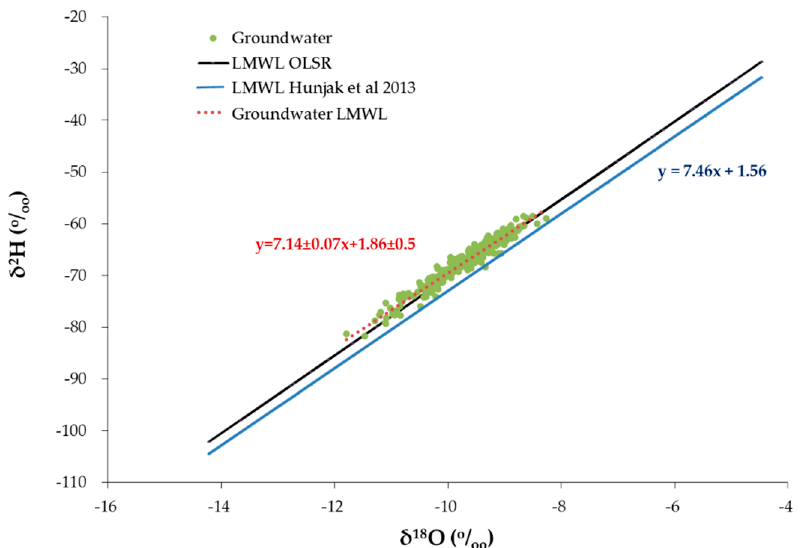
Figure 5. Distribution of groundwater δ 18 O ( o / oo ) and δ 2 H ( o / oo ) values around the local meteoric water line (LMWL).